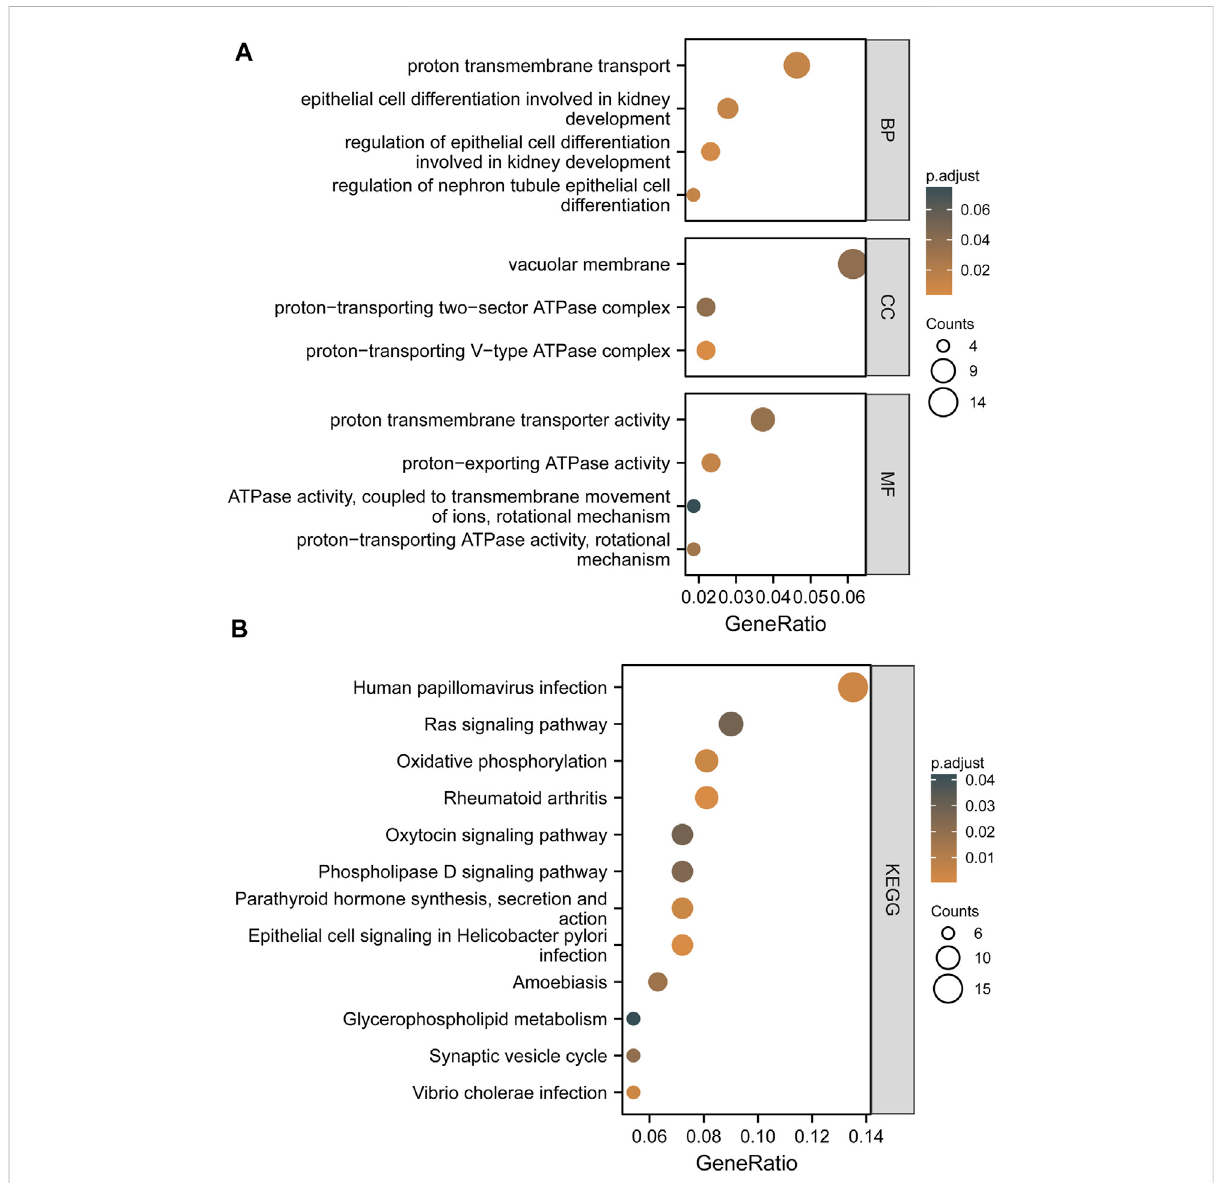
FIGURE 4 Based on TCGA and GEO, the fi ndings of GO terms and KEGG pathway enrichment of co-expressed genes between high and low ATP6AP1 expression are shown. (A) Results of GO enrichment analysis. (B) Results of the KEGG pathway enrichment